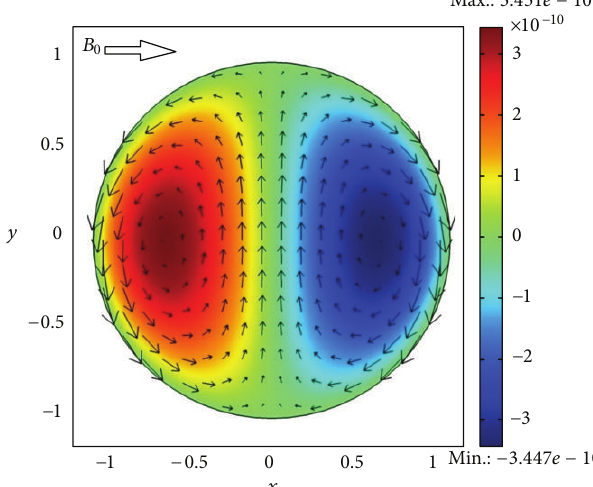
Figure 9: Variation of unsteady velocity profiles at different time within a period (6th cycle) for Re = 100 and Ha = 2 , 𝛼 = 5 .